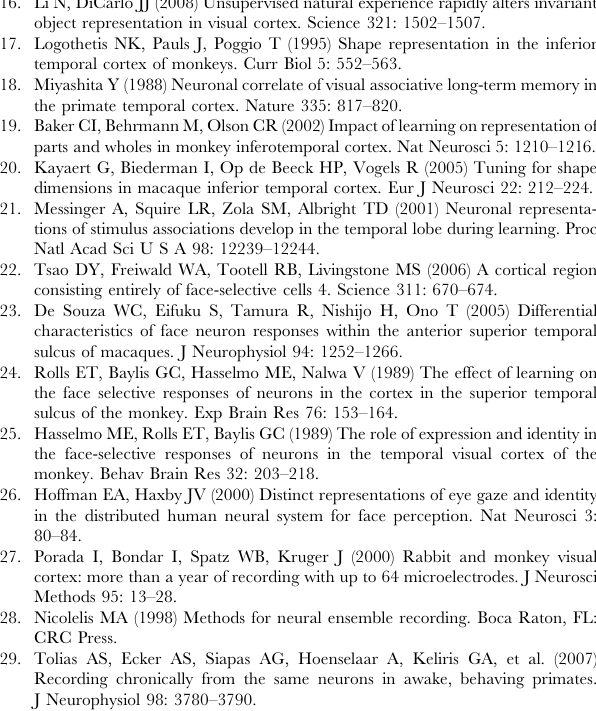
corresponding to different days. The vertical white line corre- sponds to the presentation of the visual stimulus. Figure S7 Stability of early vs. late phase responses across the population. In each case, the comparison is made between the neuron’s response on the first and last recording session. A. Early response, mean spike rate (40–160 ms). B. Late response mean, spike rate (160–440 ms). C. Ratio of early to late spiking responses. Figure S8 Distribution of duration of stable isolation of recorded cells. Data are shown separately for monkey E98 (black bars) and monkey N97 (gray bars), along with their sum (white bars). Figure S9 Interspike interval (ISI) histograms for each of 158 neurons recorded in the present study from both monkeys. In one of the neurons (red box), the ISI distribution is polluted by a periodic signal of unknown origin. Table S1 Details of ANOVA analysis for the neurons shown in Figures 1, 2 and